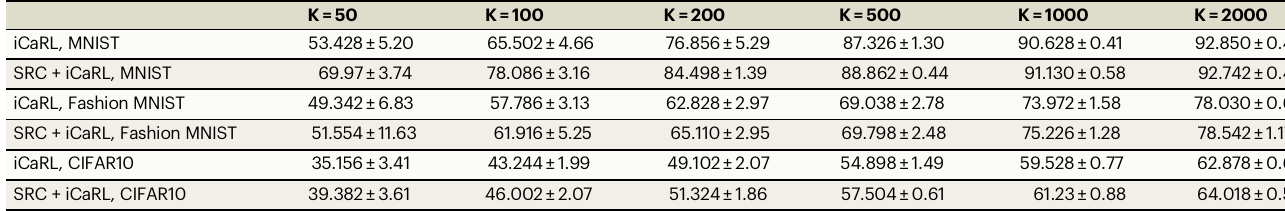
Table 2 | SRC improves upon iCaRL method with different memory capacities